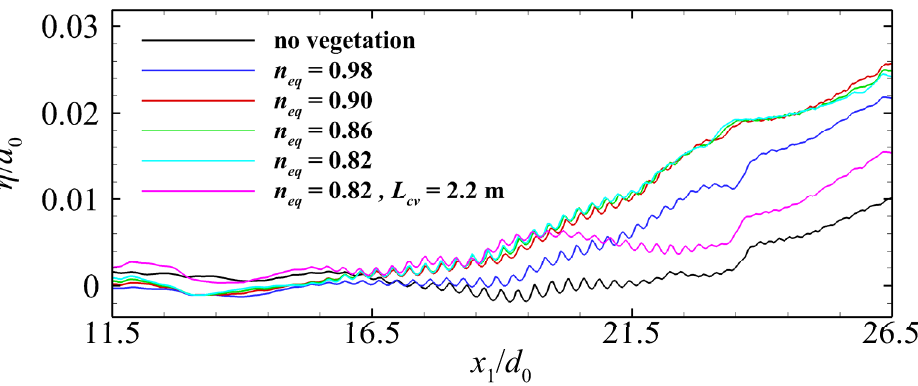
Figure 11. Period-mean free-surface level (wave setup), η , for all cases. The sloped bed starts at Figure 11. Period ‐ mean free ‐ surface level (wave setup),  , for all cases. The sloped bed starts at x 1 / d 0 = 11.5, and the still-water coastline is at x 1 / d 0 = 26.5. x 1 / d 0 = 11.5, and the still ‐ water coastline is at x 1 / d 0 = 26.5. Table 3. Wave setup at the still ‐ water coastline,  , wave runup, R u , and x 1 ‐ coordinate of the sea ‐ ward boundary of the swash zone, x 1 s .